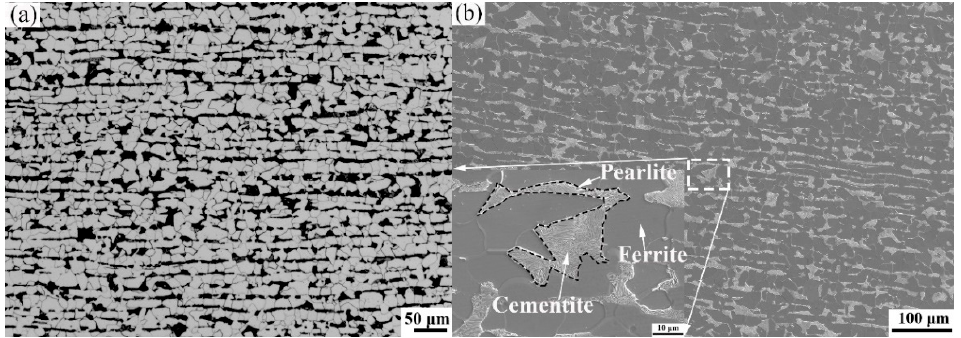
Figure 3. Corrosion rate of L245N standard steel in simulated solution after different times.